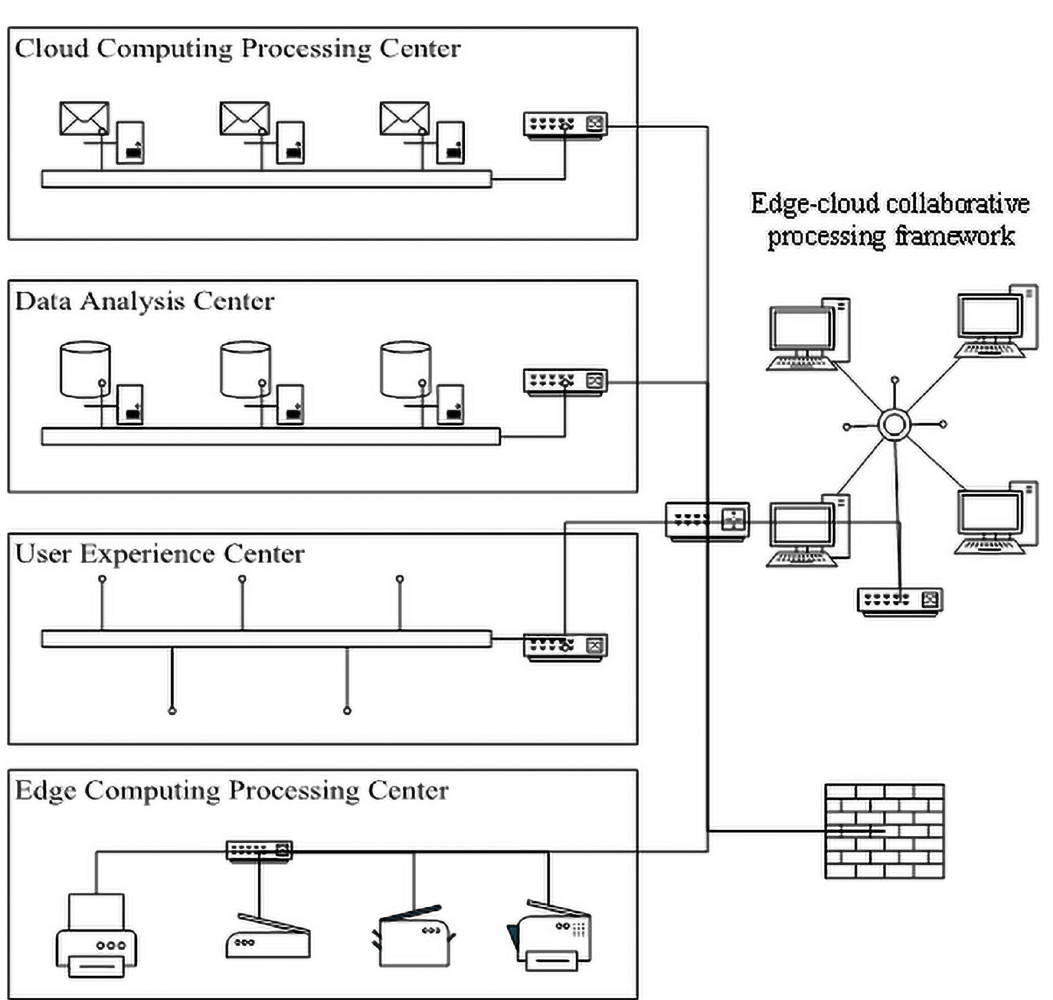
Fig 1. Edge-cloud collaborative processing